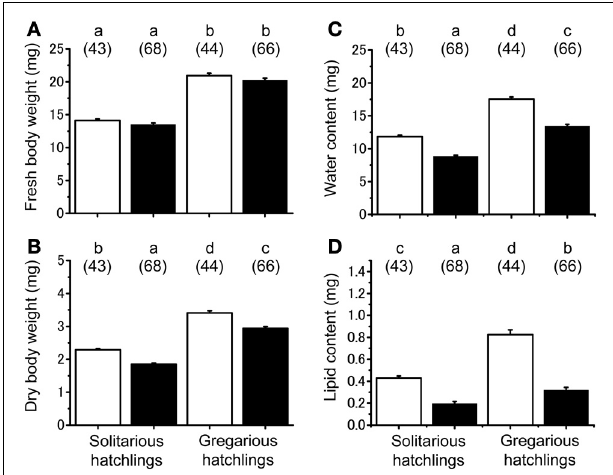
FIGURE 6 | Physiological changes associated with starvation in hatchlings produced by solitarious hatchings (from isolated-reared mothers) and gregarious ones (from crowd-reared females) in Schistocerca gregaria . (A) Fresh body weight; (B) dry body weight; (C) water content; (D) lipid content. Each variable was measured before (open bar) and after starvation (closed bar). Numbers in parentheses indicate sample sizes. Different letters above each bar indicate significant differences at P < 0 . 05 by Scheffé’s post-hoc test. Vertical lines indicate SE .